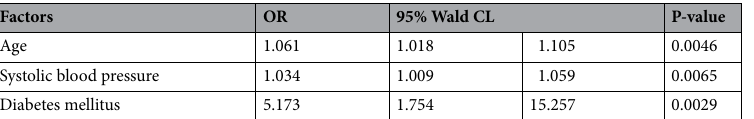
Table 2. Multivariate analysis for entire cohort. OR = Odds Ratio; C.I. = Confidence Interval; Stepwise Logistic Regression Analysis to obtain